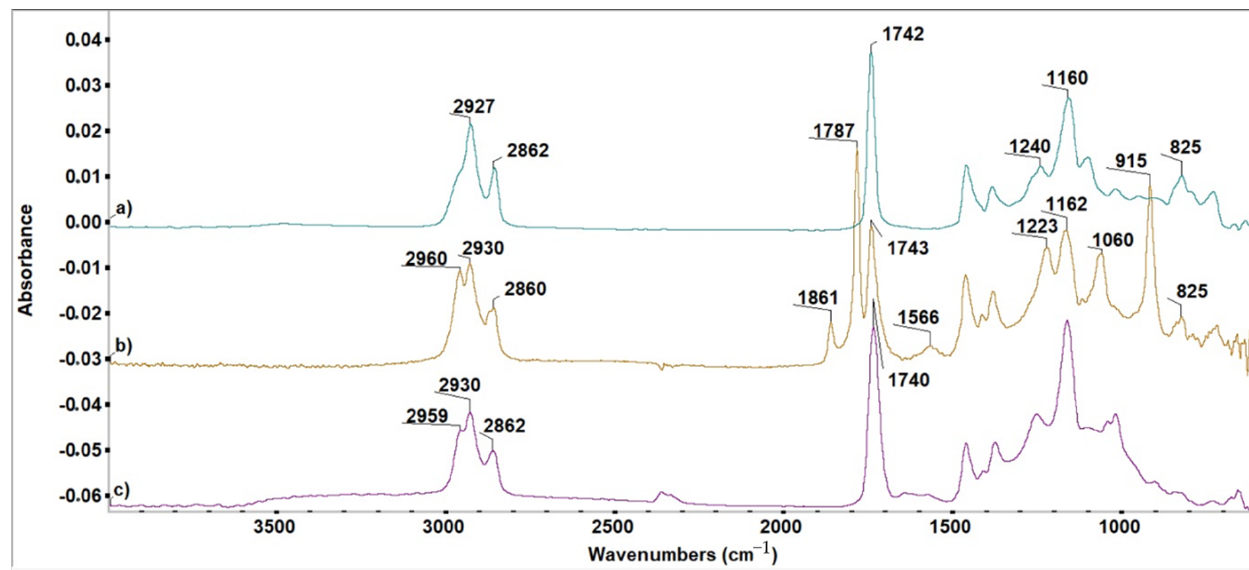
Figure 1. FTIR spectra of ( a ) ELO; ( b ) ELO-based formulation before curing; ( c ) product resulted after curing (Sr). For the ELO-LnK composites, similar findings were noticed (Figure 2).